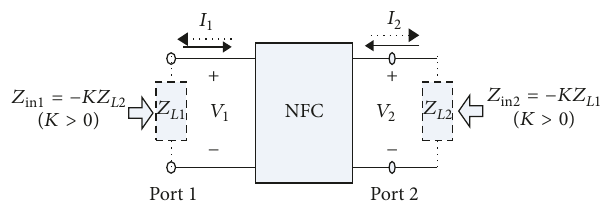
Figure 6: Ideal NFC